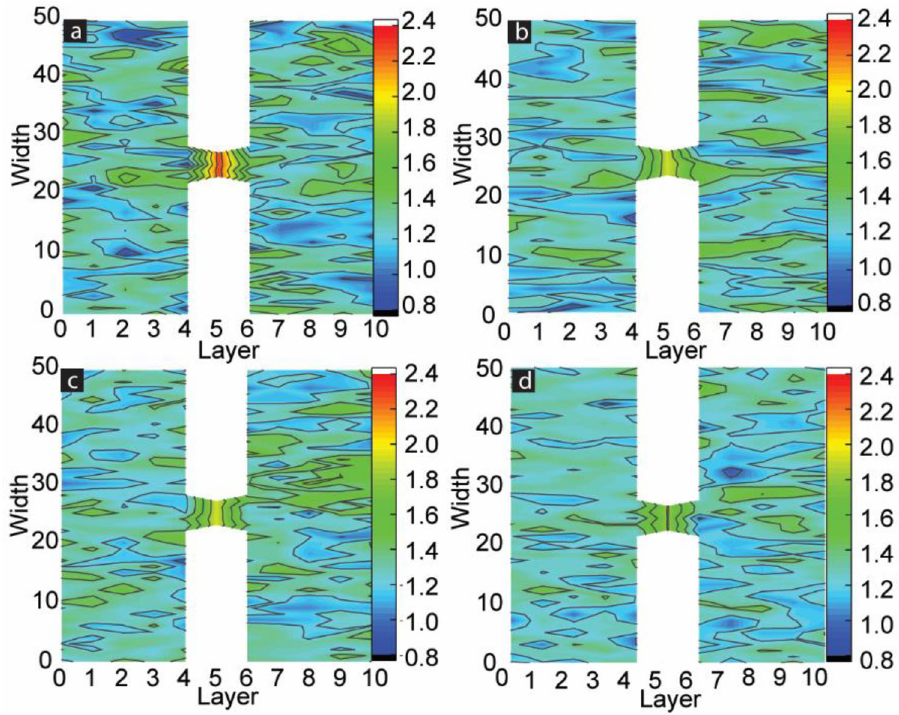
Figure 6. Contour plot of Magnetic susceptibility of MTJMSD with ( a ) A LY = 0 , ( b ) A LY = 0.1 , ( c ) A LY = 0.4 , and ( d ) A LY = 1 . No external magnetic field was